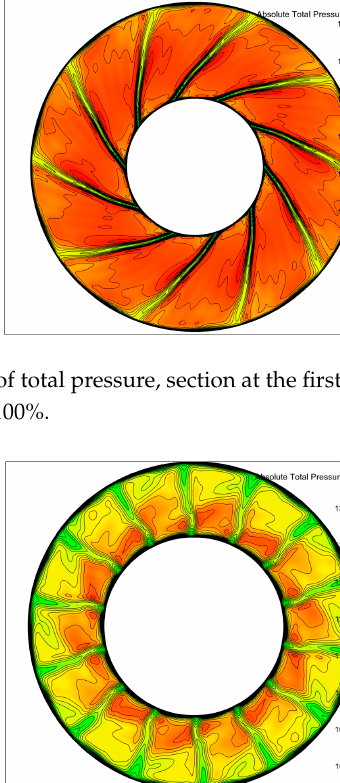
Figure 39. URANS calculations: instantaneous field of total pressure. Section 0.95 h. Operating point at n = 100%.